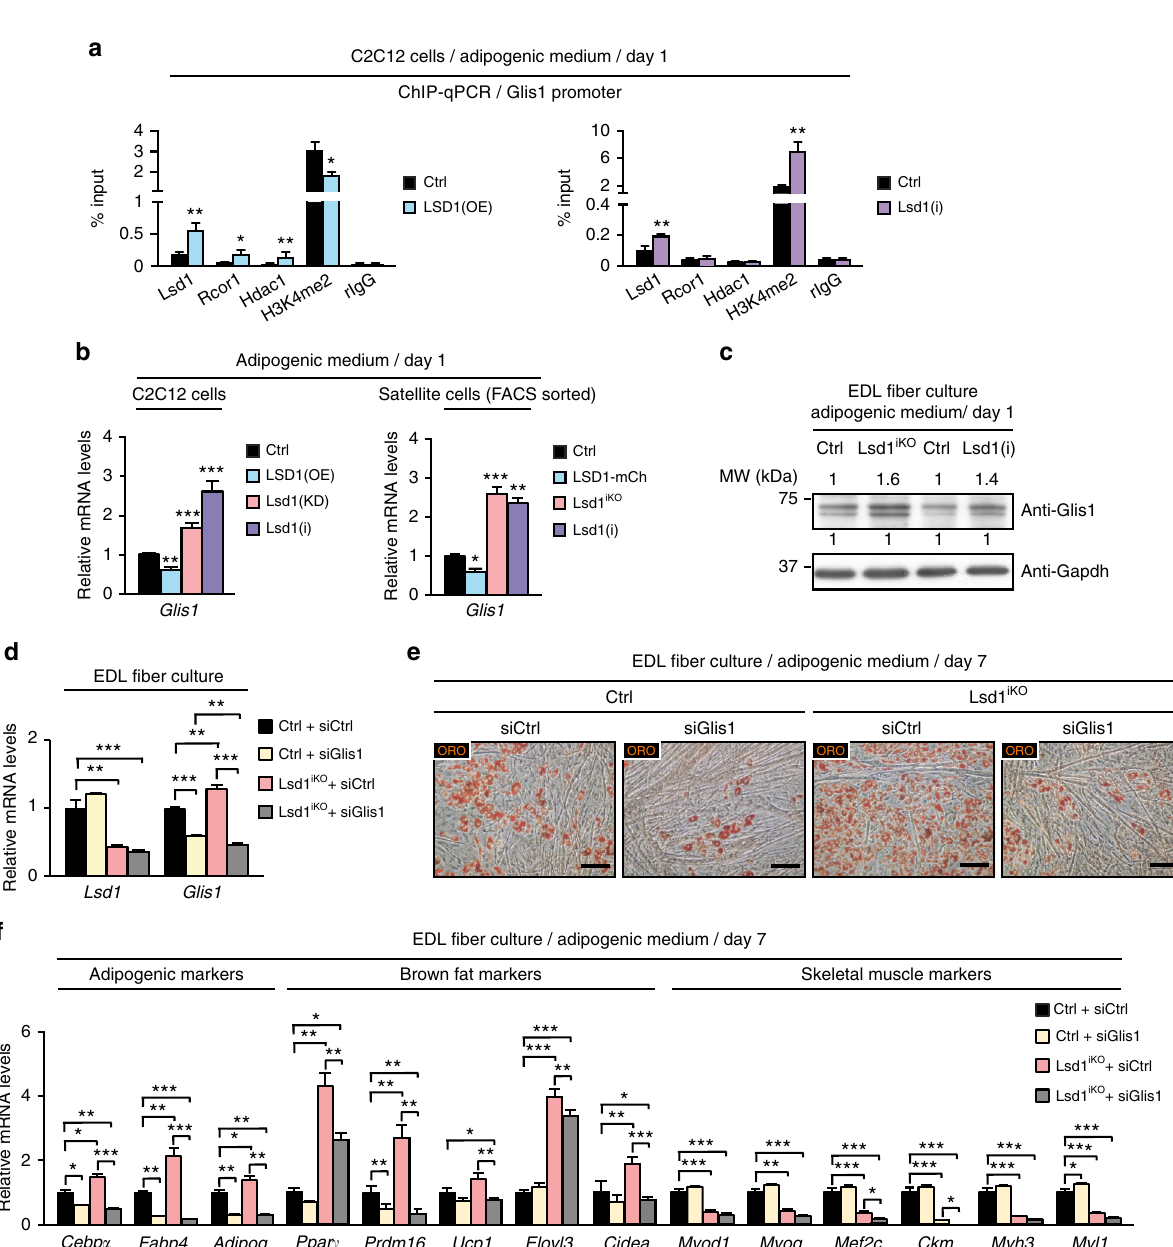
Supplementary Fig. 6a. Next, to identify genes whose expression